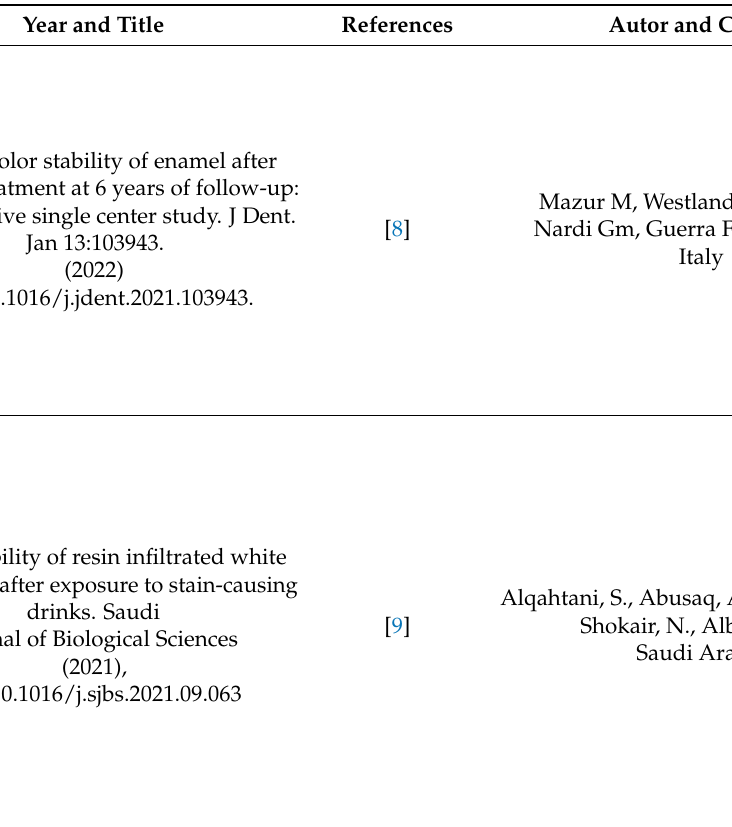
Table 2. Summary table of systematic